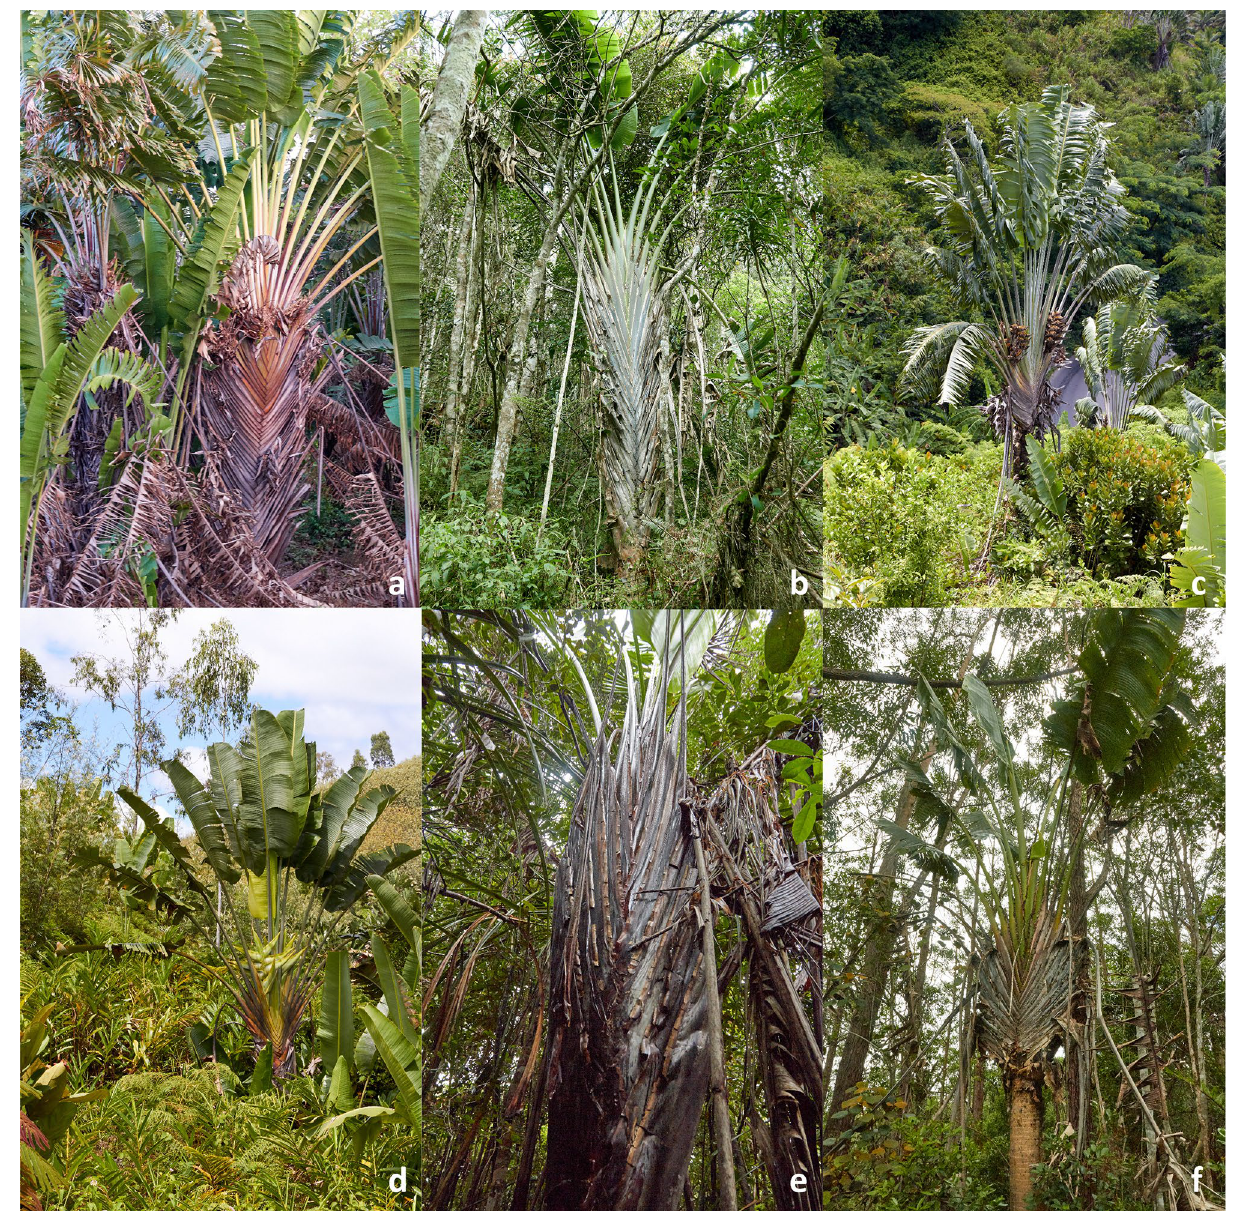
Figure 5. Species of Ravenala in their natural habitat. ( a ) R. agatheae . ( b ) R. blancii . ( c ) R. grandis . ( d ) R. madagascariensis . ( e ) R. menahirana . ( f ) R. hladikorum . Photographs Thomas